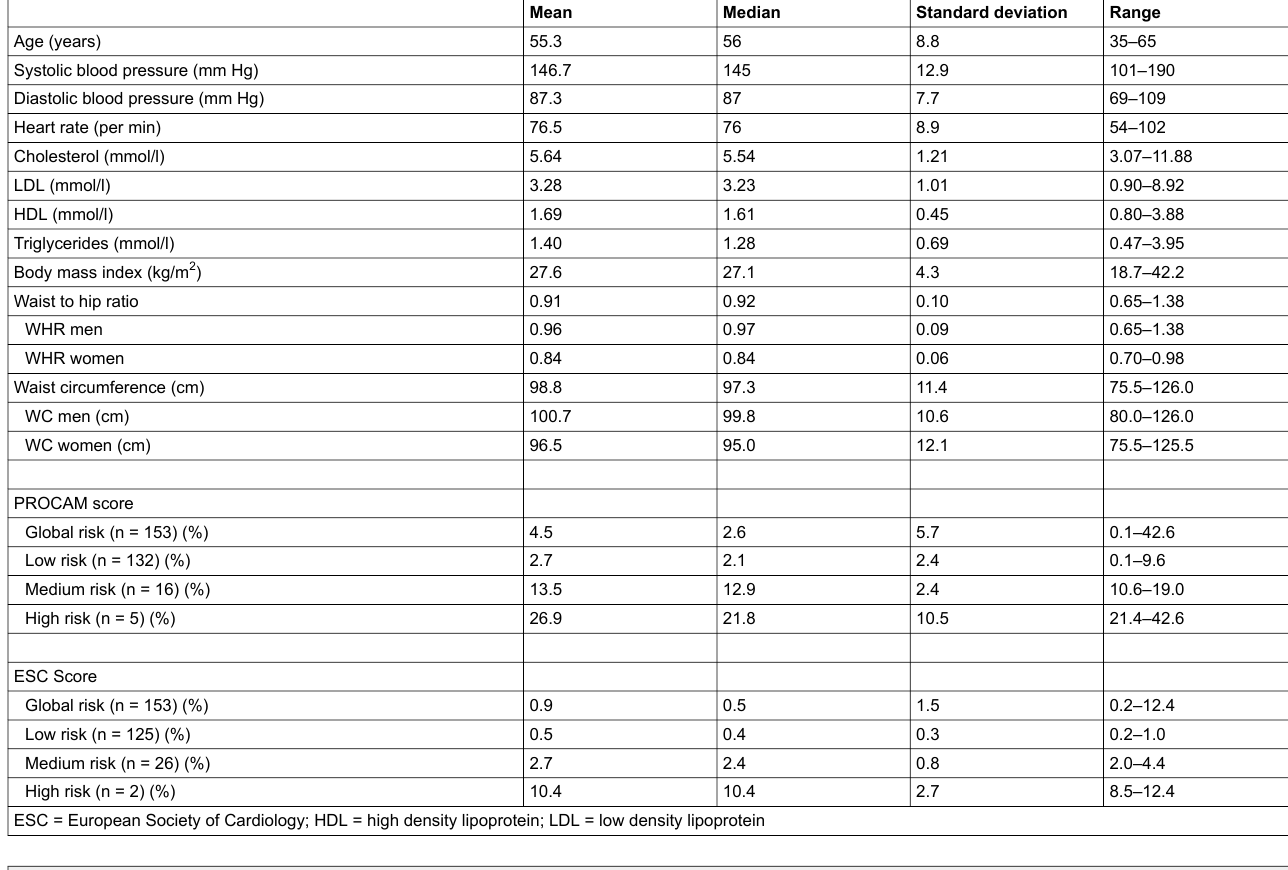
Table 1: Some quantitative characteristics of the 153 volunteers, and their PROCAM and ESC score risk levels.